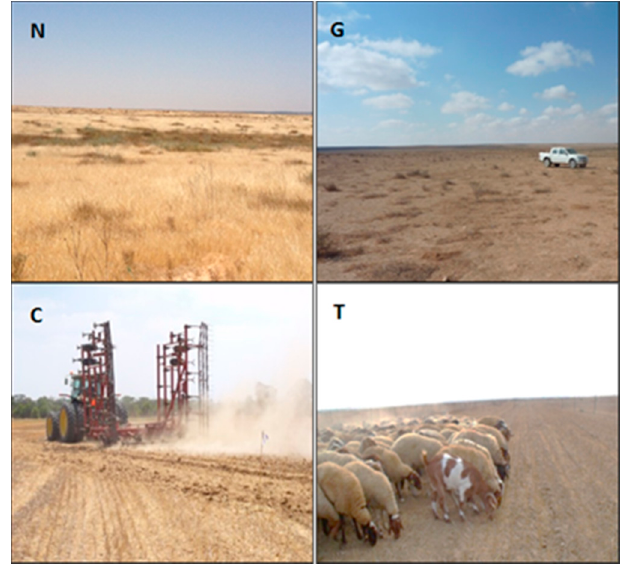
Figure 1. The experimental plots in the northern Negev: natural area ( N ), grazing ( G ), conventional agriculture practice ( C ), and traditional agriculture practice ( T ) (from Tanner et al., 2016 [20]).